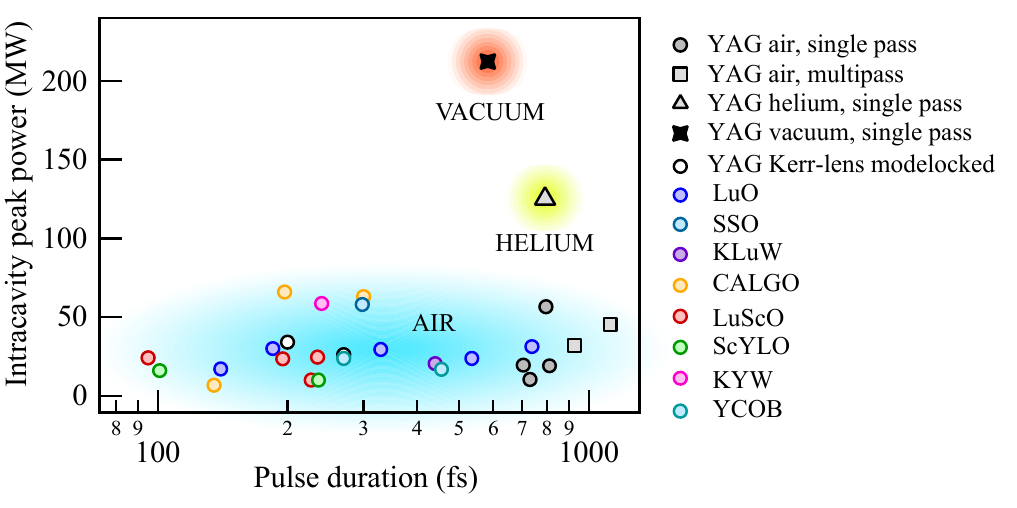
Figure 14. Intracavity peak power of modelocked TDLs demonstrated to date, showing the crucial advantage of operating such oscillators in a vacuum environment. The different colors indicate different gain materials that have already been modelocked in the thin-disk